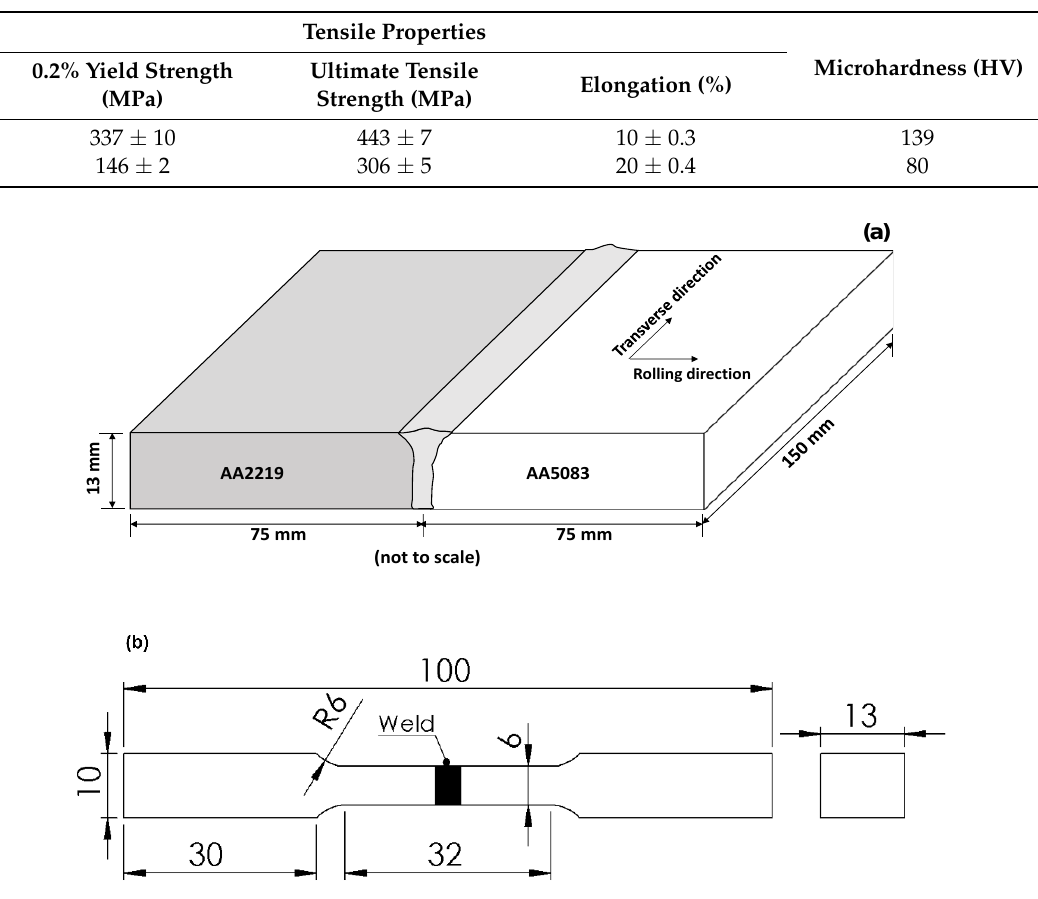
Figure 1. ( a ) Schematic arrangement of weld coupon; ( b ) schematic of the subsize tensile specimen (All dimensions are in mm). Table 3. Electron-beam welding process Table 1. Chemical composition of base materials.